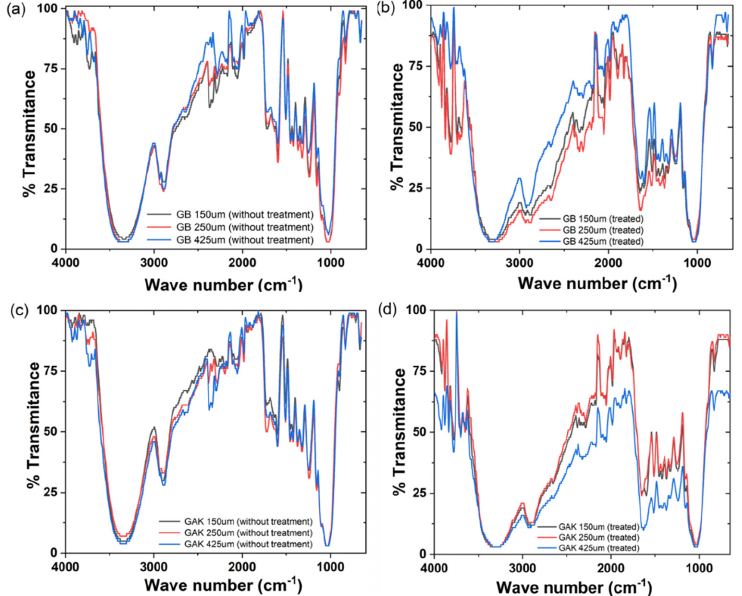
Figure 6. ATR-FTIR results of the giant bamboo (GB) and G. angustifolia Kunt (GAK) fibers at different sieves: ( a , c ) the untreated control and ( b , d ) with treatment, respectively.